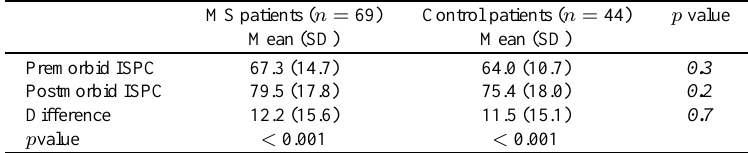
Table 2 Values for, and difference between, the global ISPC scores in the MS and control patients MS patients ( n =